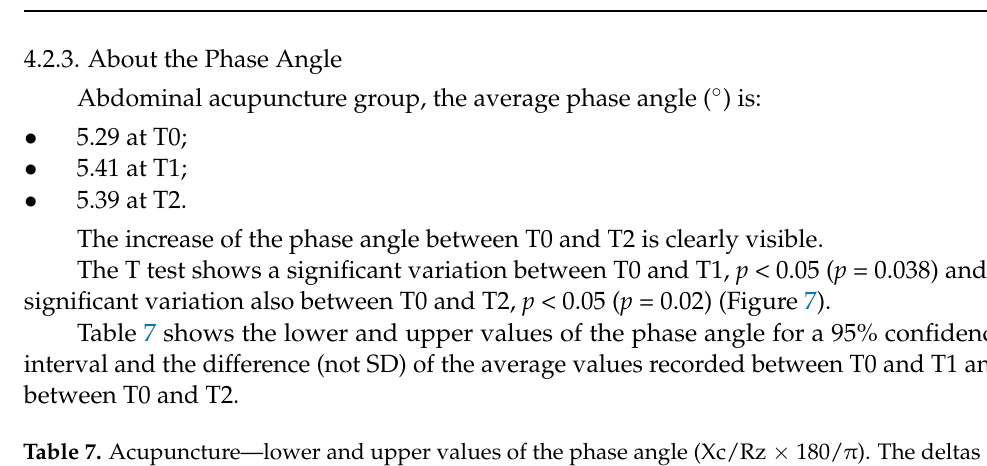
Table 6. Acupuncture— lower and upper values of reactance (Ω). The deltas of the average reactance values ( Δ To ) are included.